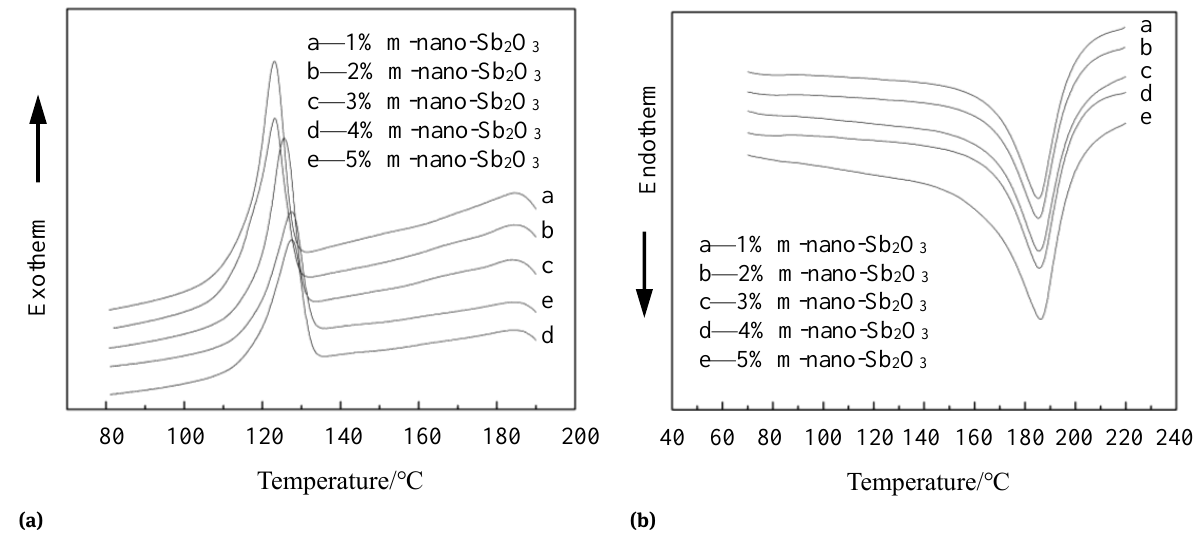
Figure 7: DSC crystallization curve and melting curve of the experimental nano-Sb 2 O 3 /BPS-PP composites (a) DSC crystallization curve; (b) DSC melting curve